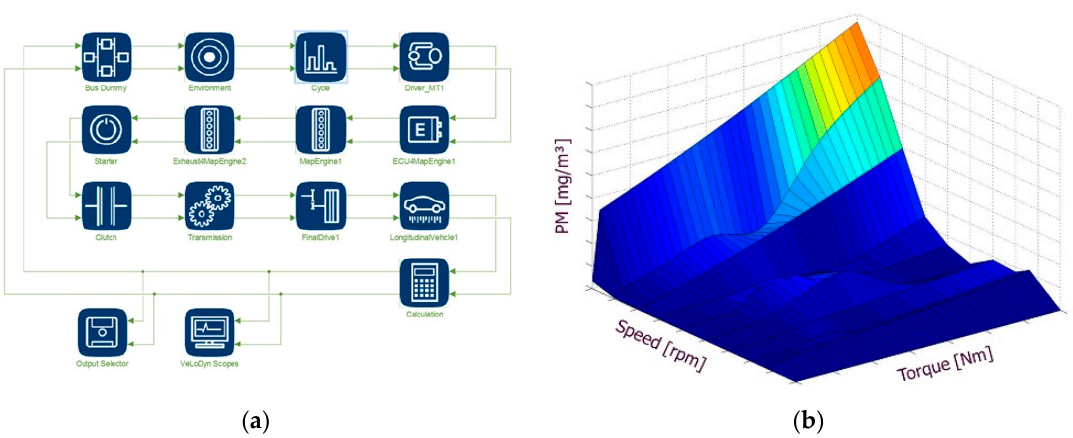
Figure 7. ( a ) Overview of the VeLoDyn model for simulation of engine-out soot emissions; ( b ) soot map used for calculation of engine-out soot emissions in every time step according to engine speed and torque which are provided by the vehicle’s engine control unit (ECU).